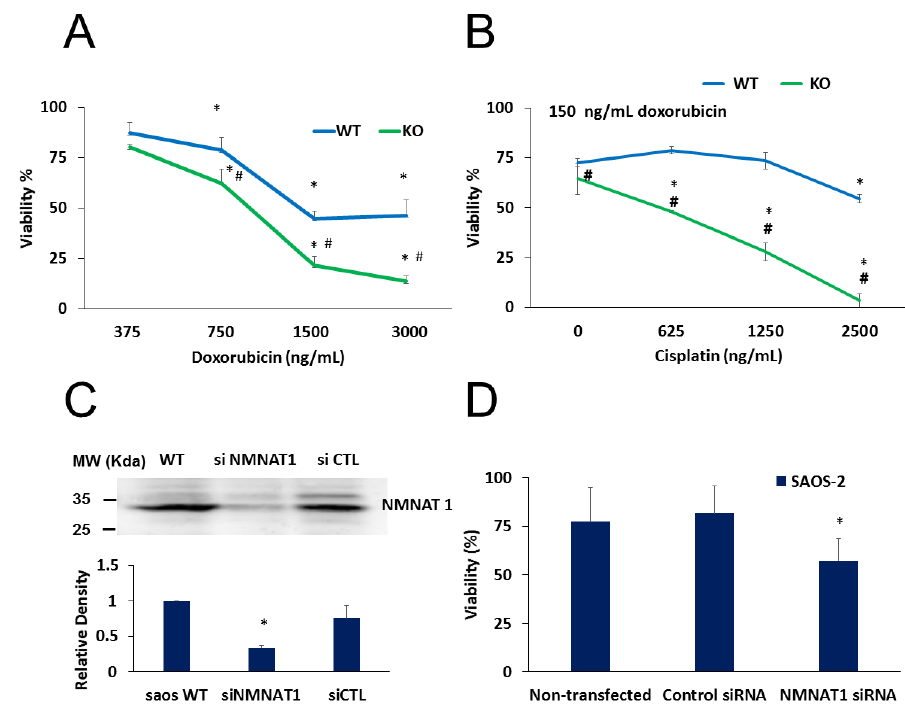
Figure 7. Combined treatments on U-2OS WT and NMNAT1 −/− cells, chemosensitivity of SAOS-2. Wild type (WT) and NMNAT1 −/− cells were treated with the indicated concentrations of doxorubicin (DOX) and viability was determined with the Calcein-AM assay 24 hours after DOX treatment. Data points marked with asterisks are significantly different from the corresponding vehicle treated data points (not shown) (Dunnett test; * p < 0.05). Data points marked with hashmarks are significantly different from the corresponding data points of wild type cells (Student – Newman – Keuls method; # p < 0.05) ( A ). DOX was also applied in combination with cisplatin ( B ). Panel B shows the viability of WT and KO at constant (150 ng/mL) DOX and increasing cisplatin concentrations. Data points marked with asterisks are significantly different from the corresponding vehicle treated data points (Dunnett test; * p < 0.05). Data points marked with hashmarks are significantly different from the corresponding data points of wild type cells (Student – Newman – Keuls method; # p < 0.05). SAOS-2 cells were transfected with control or NMNAT-1 specific siRNAs. Efficiency of NMNAT-1 silencing was verified by Western blot ( C ). Full WB image can be found in Supplementary Material. Cells were treated with cisplatin for 48 hours and a Calcein-AM viability assay was performed ( D ). Data points marked with asterisks are significantly different from the vehicle-treated sample (Dunnett test; * p < 0.05). Data plotted are means ± SEM ( n = 3).